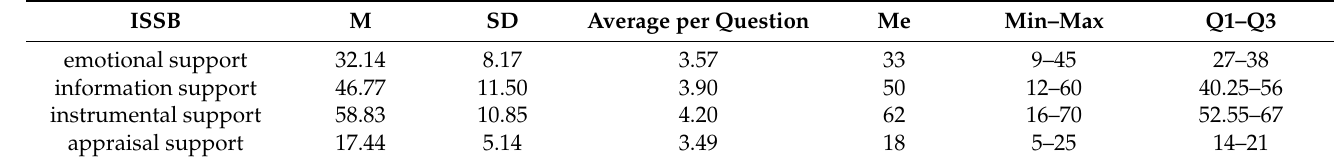
Table 1. Social support according to